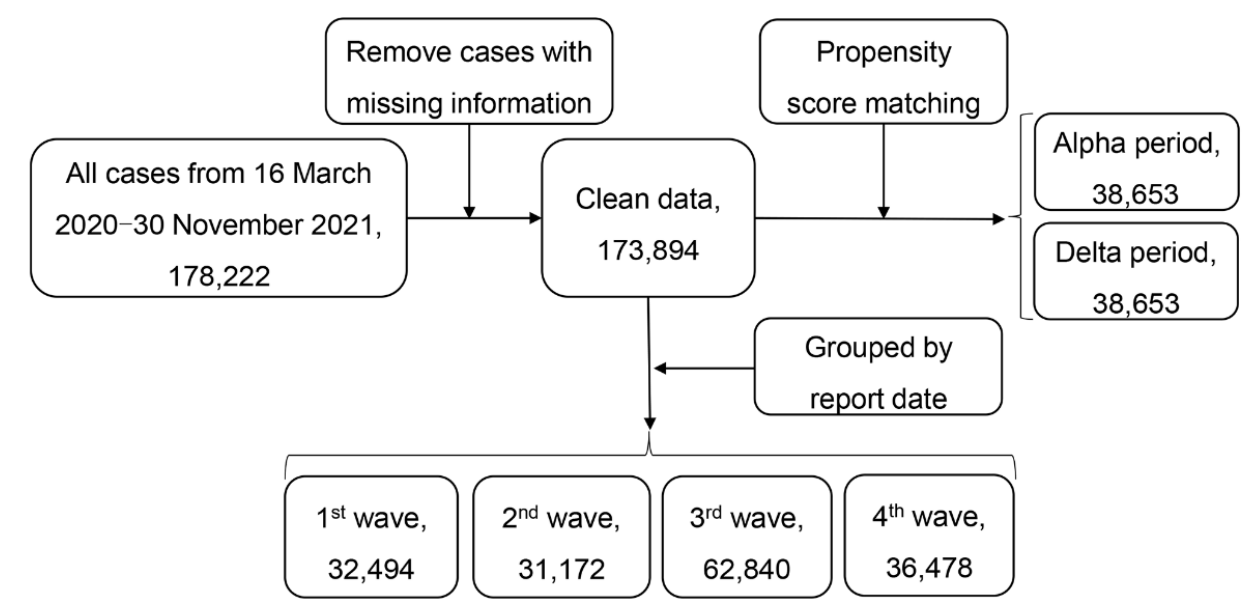
Figure 2. Flowchart of data selection.